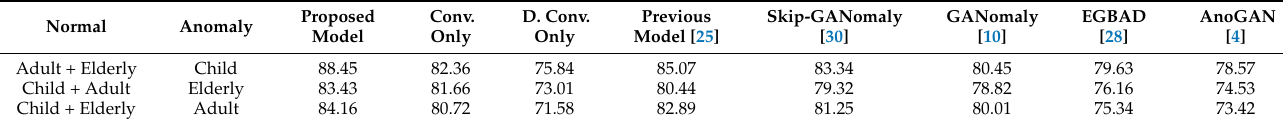
Table 3. The results for the area under the curve (AUC) of receiver operating characteristics (ROC) of the proposed model, the previously proposed model for Alzheimer’s disease anomaly detection, the ablation study of the single convolutional pipeline as well as the single dilated convolutional pipeline, Skip-GANomaly, GANomaly, EGBAD, and AnoGAN. Normal Anomaly Proposed Model Conv. Only D. Conv. Only Adult + Elderly